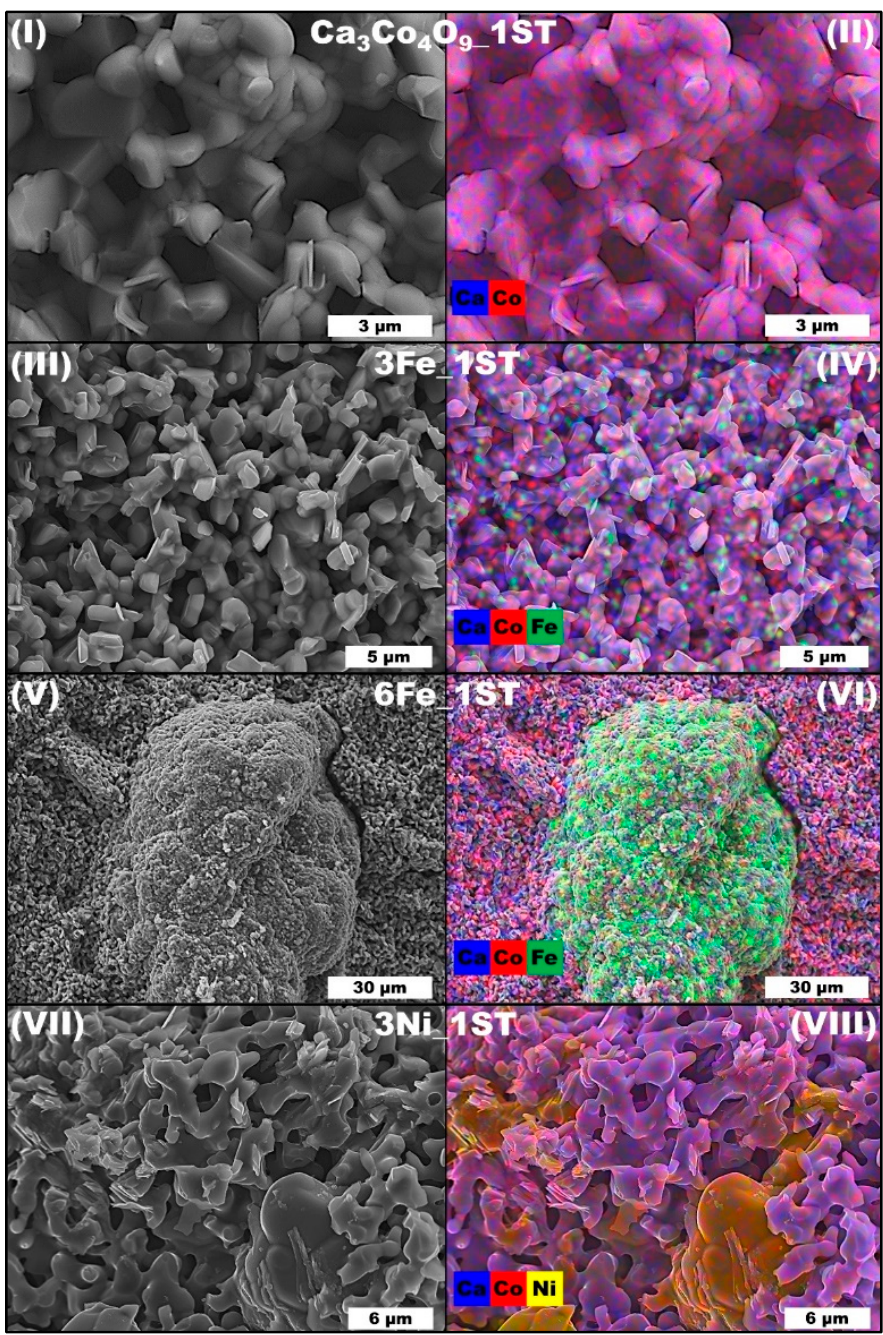
Figure 3. Representative SEM micrographs ( I , III , V , VII ) and EDS maps ( II , IV , VI , VIII ) of selected 1ST sintered samples (fractures).